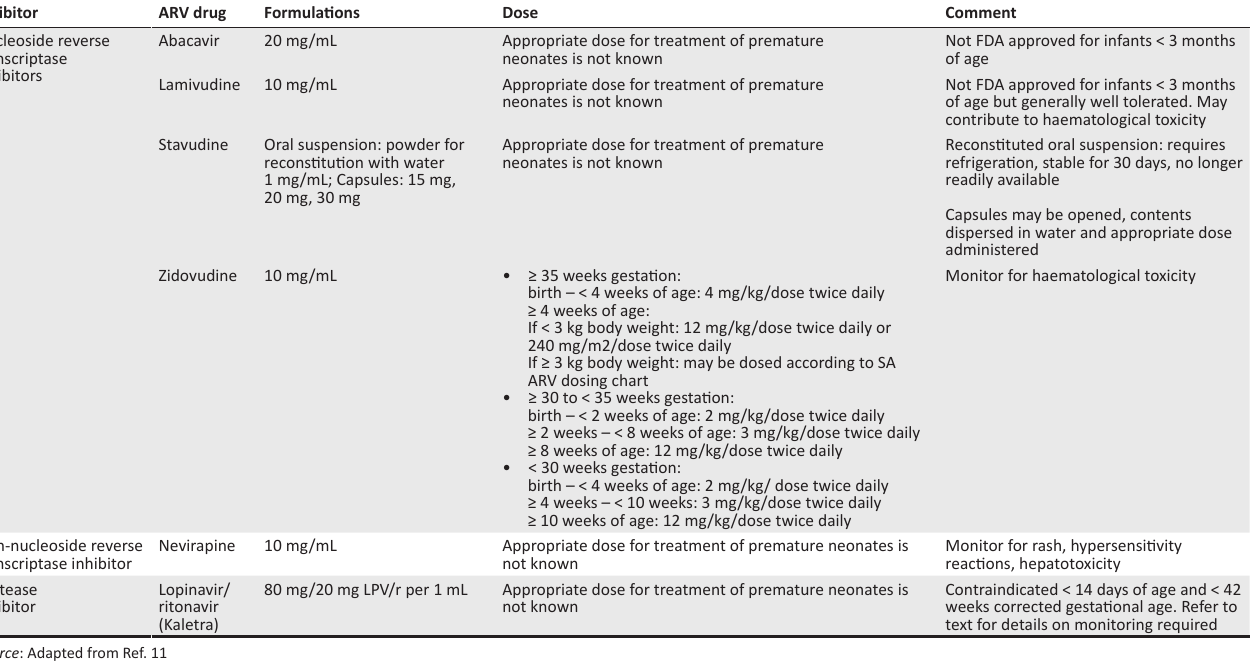
TABLE 2: Antiretroviral drugs, formulations and dose recommendations for treatment of premature neonates. Inhibitor ARV drug